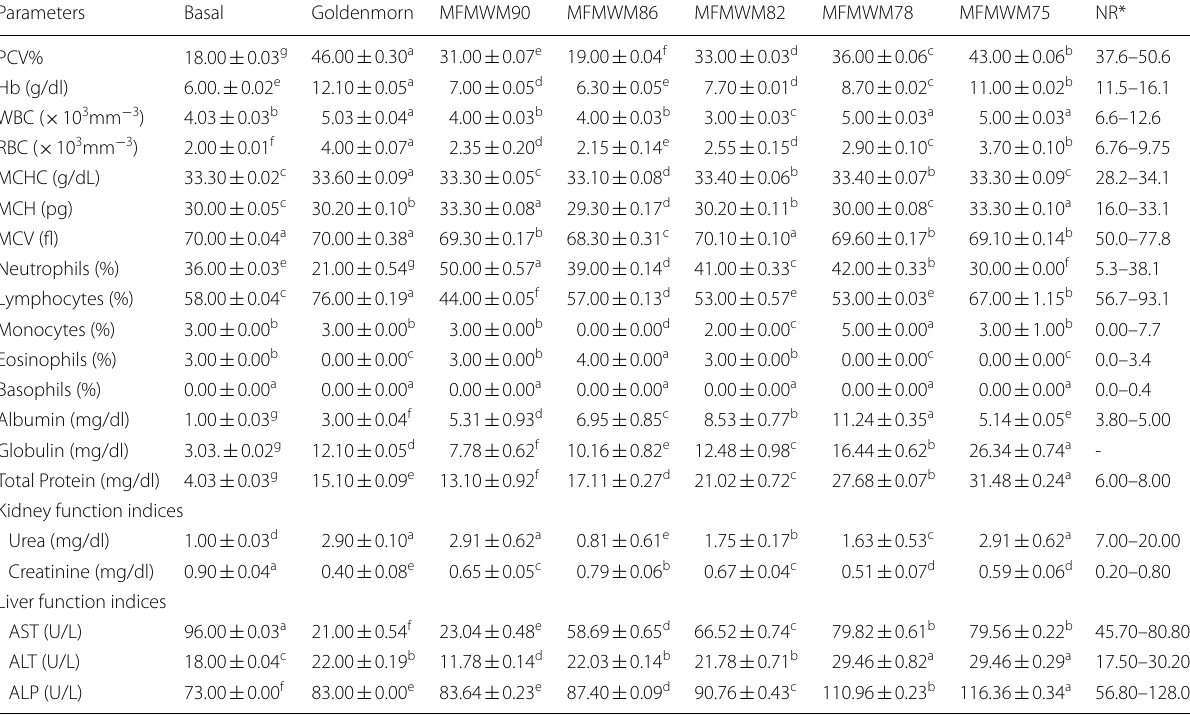
Means with different alphabetical superscripts in the same row are significantly different at P < 0.05 Key: Basal (animal chow); Goldenmorn (commercial control breakfast meal); MFMWM90: Malted finger millet:Watermelon seeds (90.00:10.00%); MFMWM86: Malted finger millet:Watermelon seeds (86.25:13.75%); MFMWM82: Malted finger millet:Watermelon seeds (82.50:17.50%); MFMWM78: Malted finger millet:Watermelon seeds (78.75:21.25%) and MFMWM75: Malted finger millet:Watermelon seeds